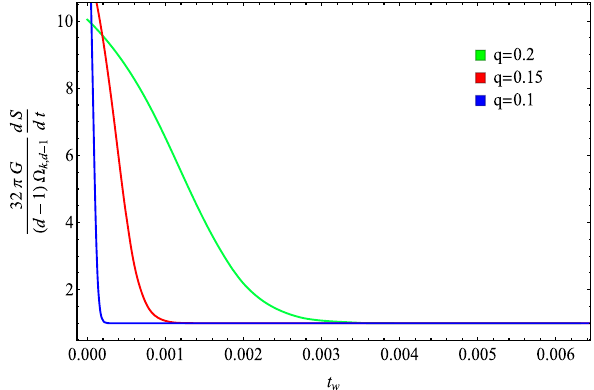
dishes lines describe the corresponding scrambling time t = t ∗ scr . The right panel illustrates the behaviour for the heavy shock wave with d = 3 , k = 0 , l ct = 1 , L = 1 ,ω 1 = 1 ,w 2 = 2